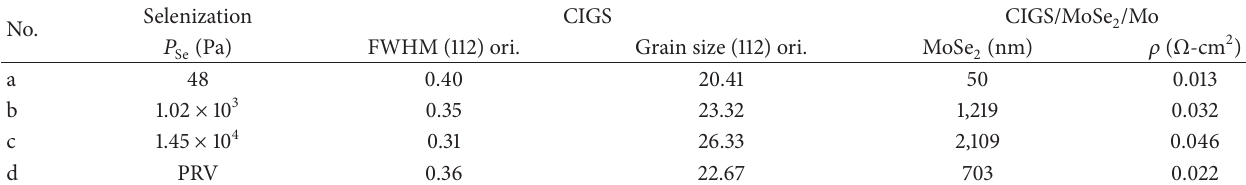
films with various selenization pressures. 2